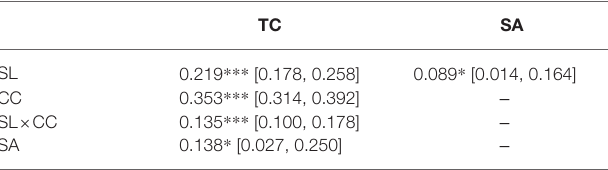
TABLE 3 | Unstandardized coefficients for testing main effects and moderation effects.